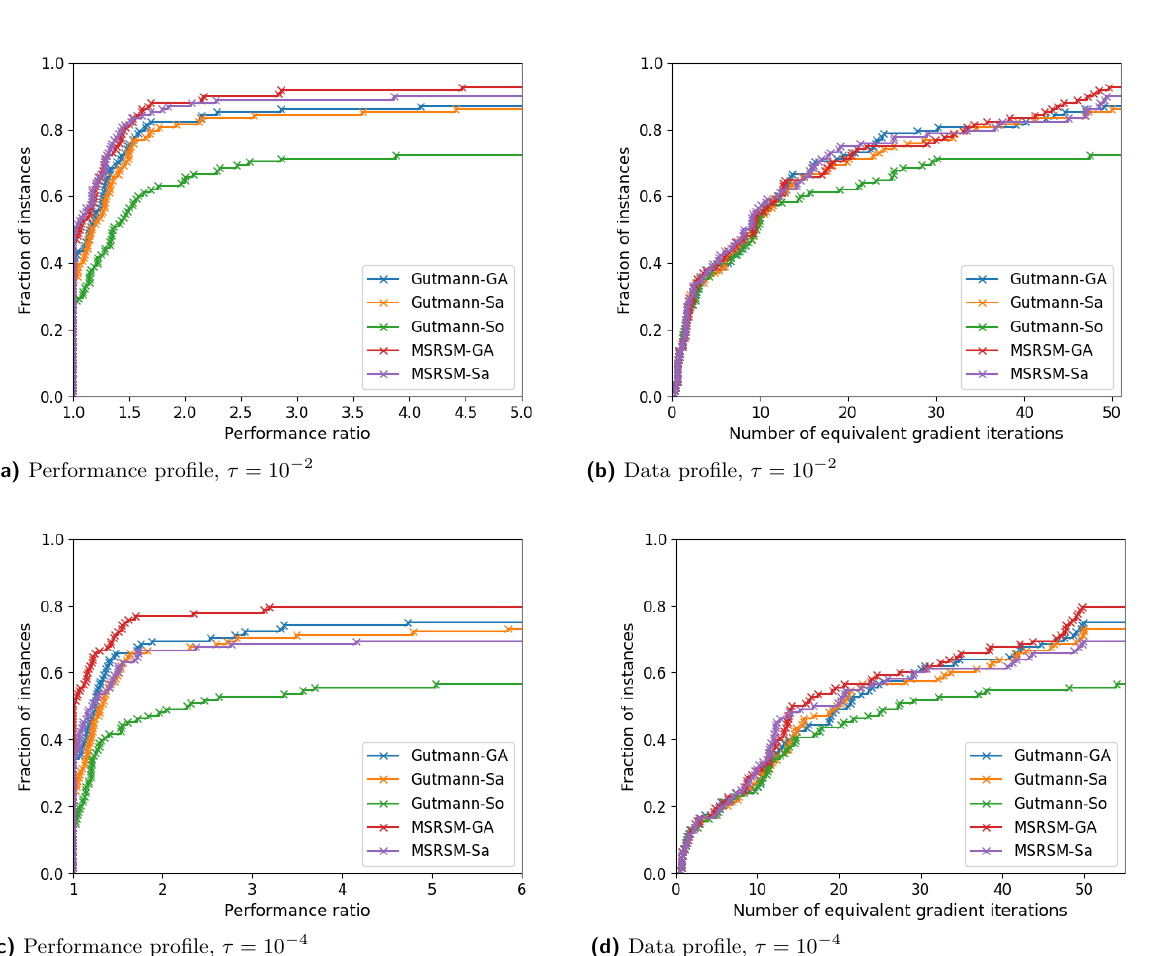
Figure 1 Performance profiles (left) and data profiles (right) for different Iteration step procedures. Legend: GA = genetic algorithm, Sa = sampling method, So = mathematical optimization